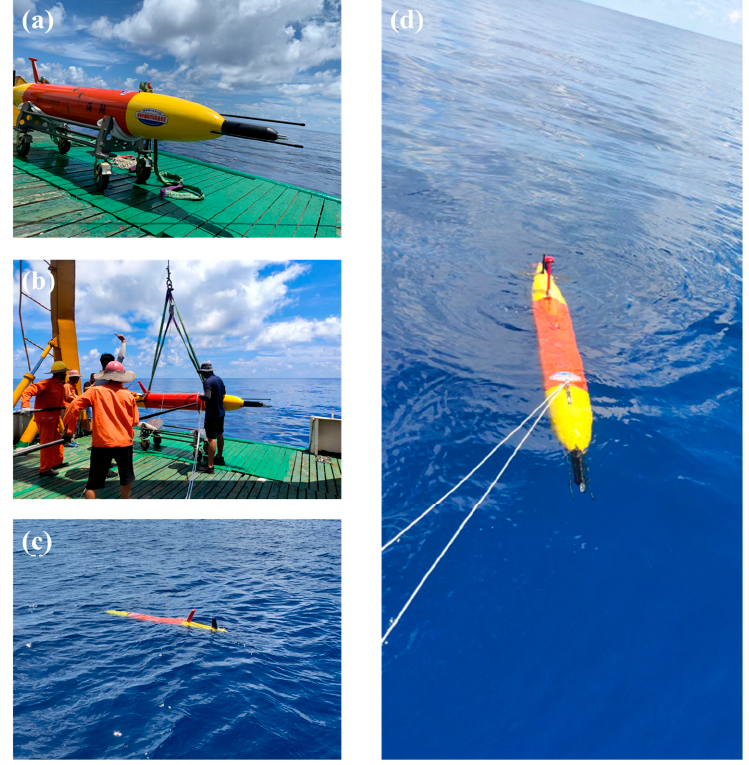
Figure 4. Deployment of the hybrid AUV from R/V Yuezhanyuke 8: ( a ) the hybrid AUV is ready on the deck, ( b ) the hybrid AUV is attached to the cables and lowered into the water through the A-frame of the R/V , ( c ) the hybrid AUV is released and starts work, and ( d ) the hybrid AUV back to the surface and retrieved.